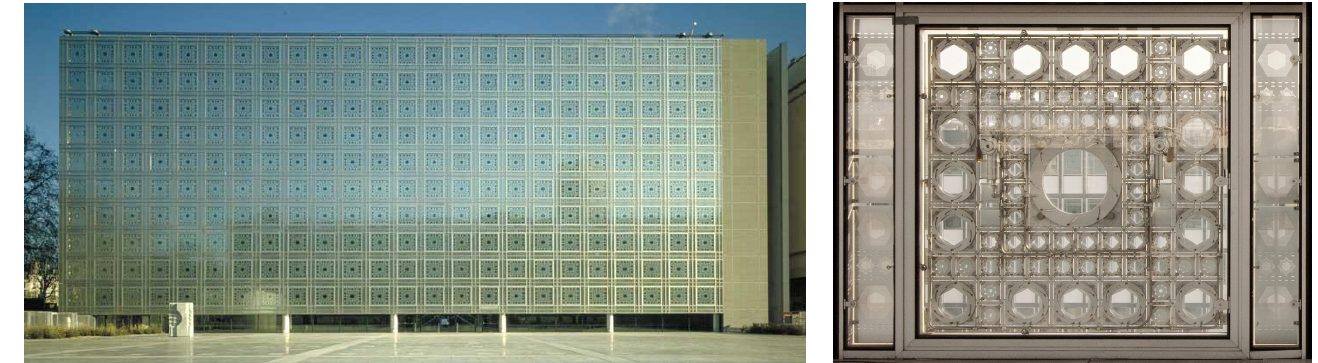
Figure 1. Left, Arab du Monde institute façade. Right, façade unit. Source: authors.